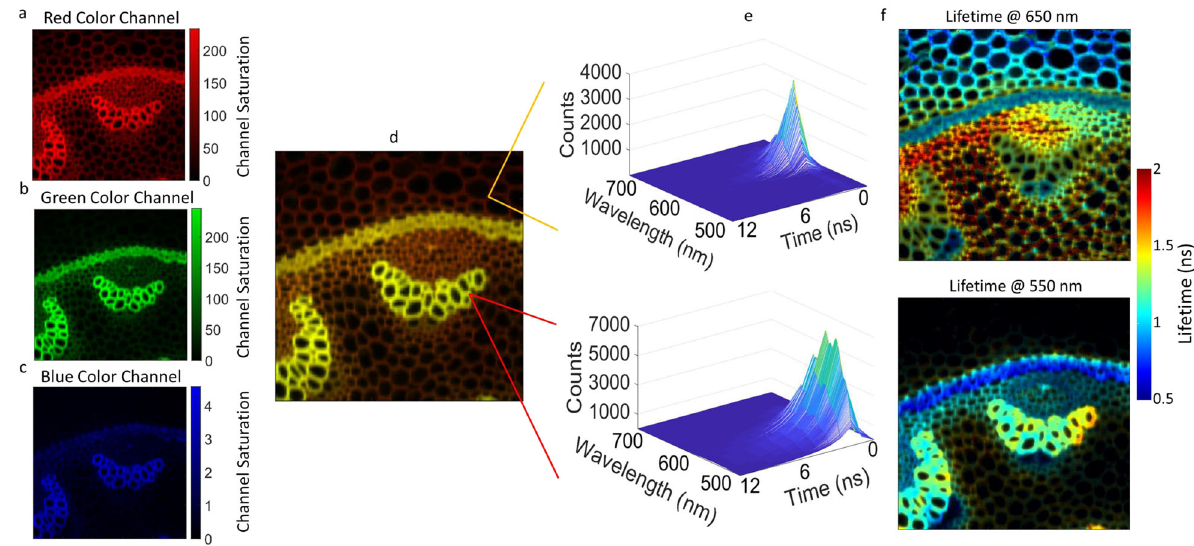
Fig. 2 FS-FLIM of Convallaria majalis and spectral color mapping. a – c Color channels assigned from the sensor spectral channels. d The combined RGB pixel data producing a color image (256 × 256 pixels with an image size of 600 × 600 μ m). e Two contrasting pixels selected and their full spectral lifetime data cubes revealing the large variation in FS-FLIM data across the image with an area dominated by Fast Green (650 nm) and the Safranin (550 nm). f Two slices through the data cubes showing lifetime at two different wavelengths and showing variation in lifetime across the sample. The sample was imaged 3 times to insure repeatability.